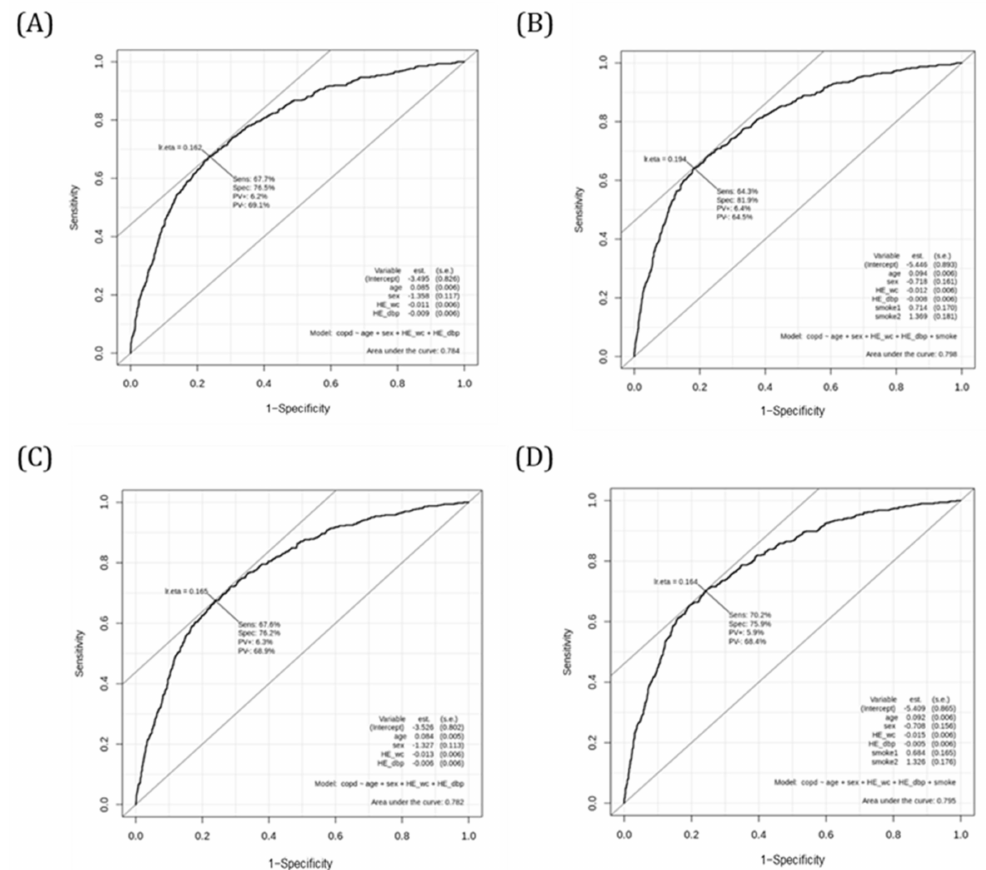
Figure 2. Receiver operating characteristic curves evaluating the performance of the COPD score for COPD in the validation cohort. ( A ) Receiver operating characteristic curve for non-CVD validation cohort with no smoking. ( B ) Receiver operating characteristic curve for non-CVD validation cohort with smoking. ( C ) Receiver operating characteristic curve for validation cohort including CVD with no smoking. ( D ) Receiver operating characteristic curve for validation cohort including CVD with smoking. Table 5. Performance of the COPD score for CVD, CHD and stroke. Estimate OR (95% CI) p